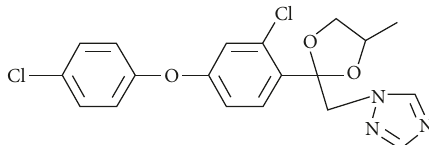
Figure 1: The molecular structure of